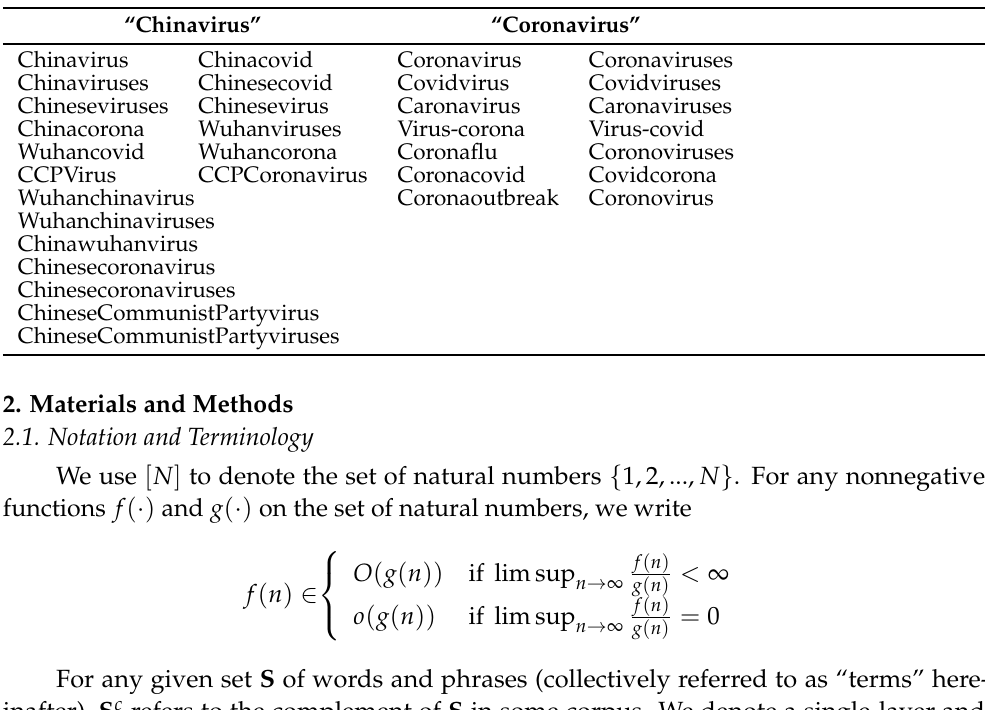
Table 1. Equivalence classes of target